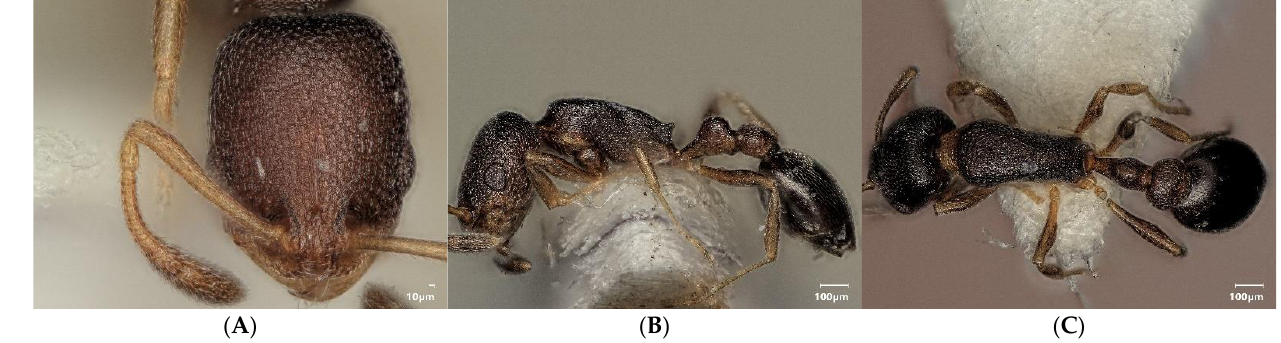
Figure 2. Cardiocondyla minutior : head in dorsal view ( A ), lateral view ( B ), dorsal view ( C ).